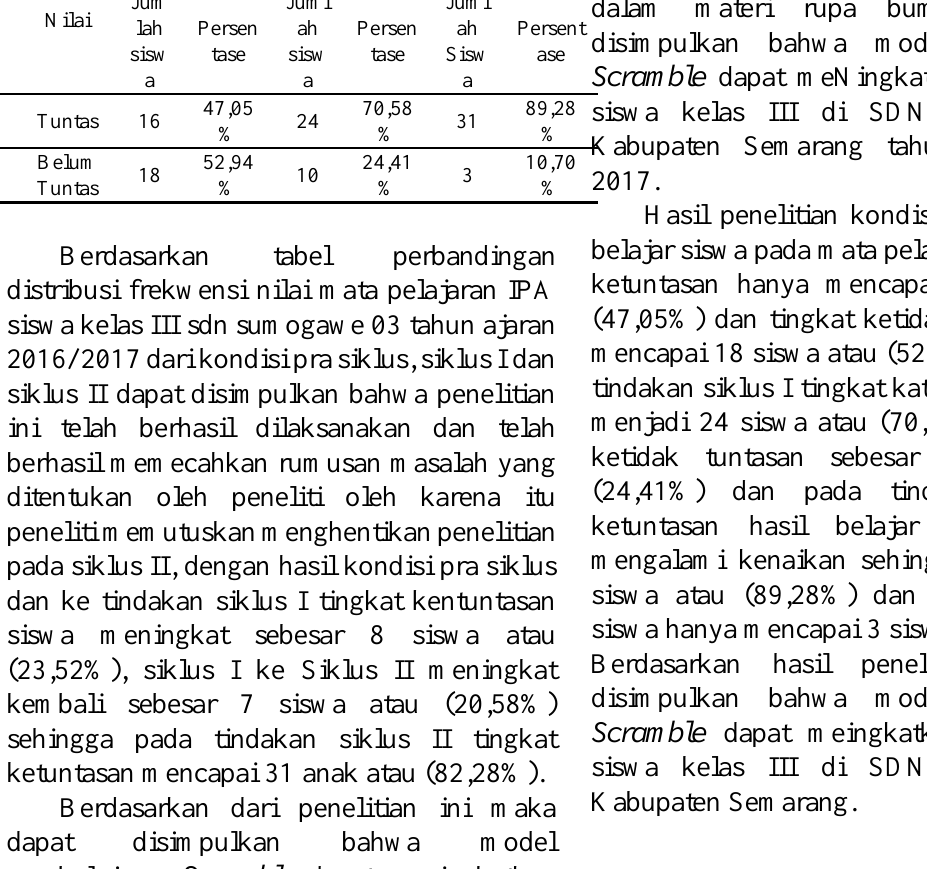
Peningkatan Hasil Belajar IPA.....(Metta Ariyanto)